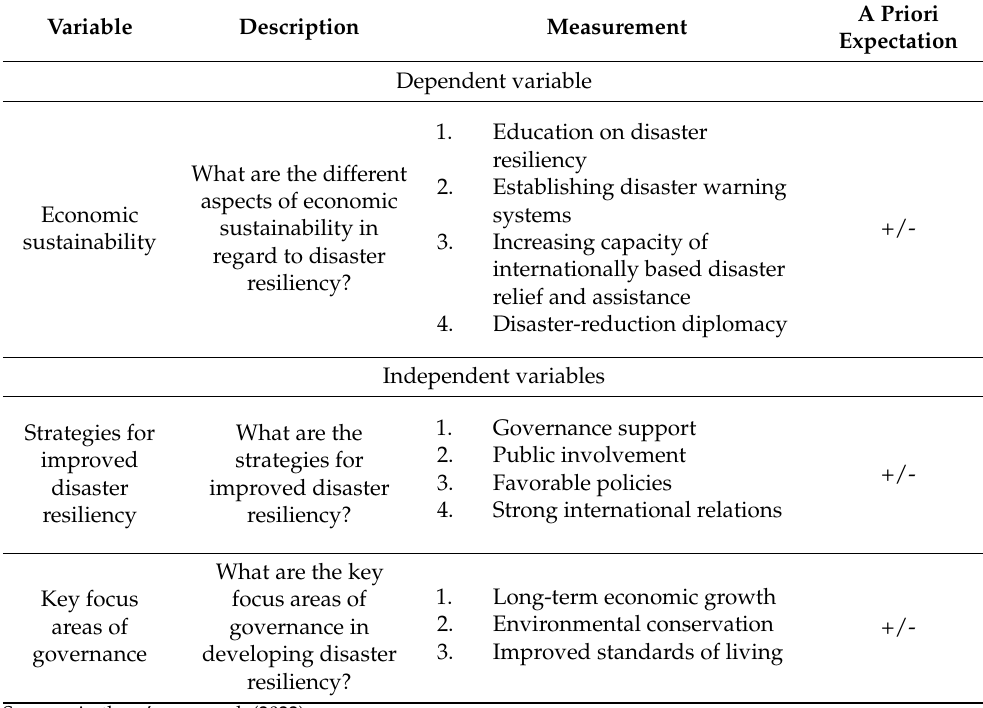
Table 2. Variables, guiding questions, measurements, and expected signs. Variable